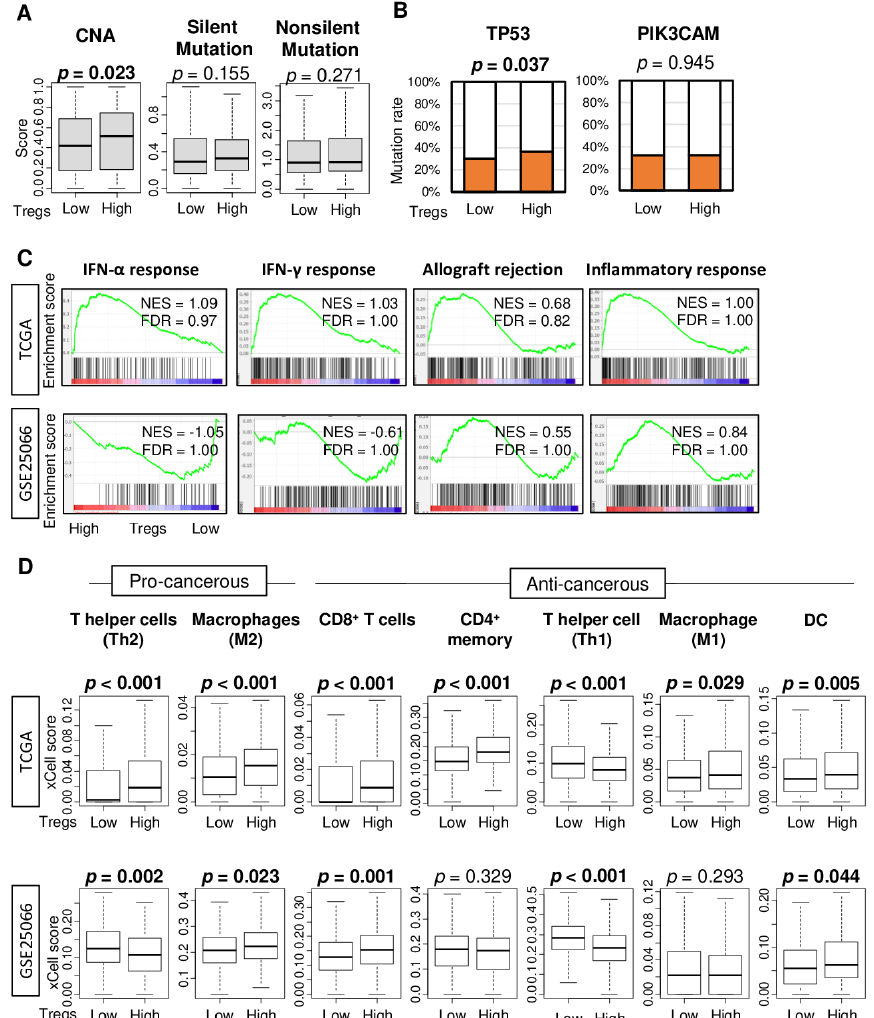
survival (OS) stratified by Tregs levels ( low (blue line) and high (red line)) within whole tumors, estrogen receptor (ER)-positive/human epidermal growth factor receptor 2(HER2)-negative, and triple negative breast cancer (TNBC) in the TCGA and GSE25066 cohorts. The top tertile percent was used as a cut-off between high and low Tregs groups within each cohort. Log-rank test with Kaplan- Meier survival curves was used for the survival analysis.